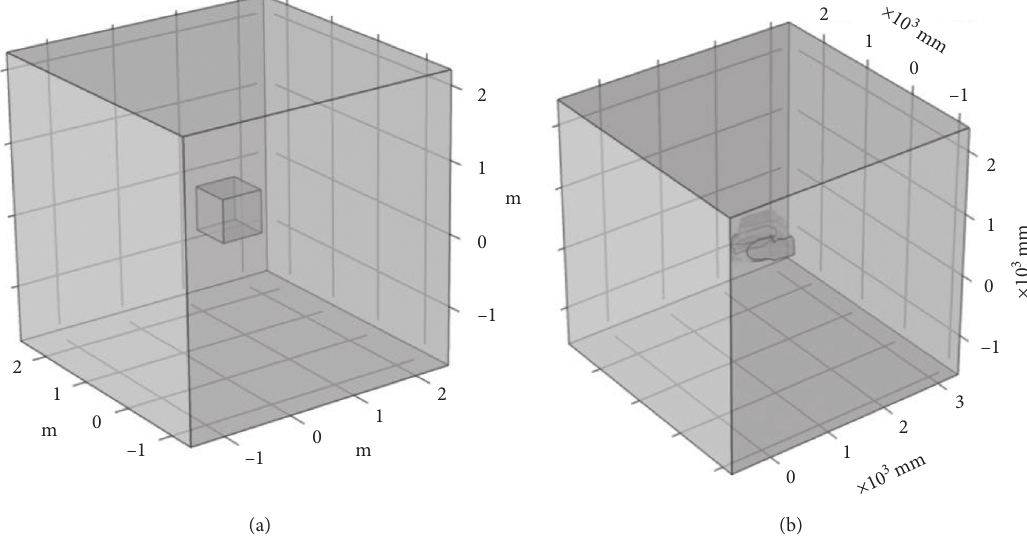
Figure 14: Geometric calculation model. (a) Cube. (b)